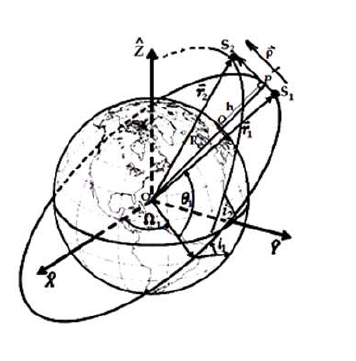
Fig. 1 Geometry of Satellites